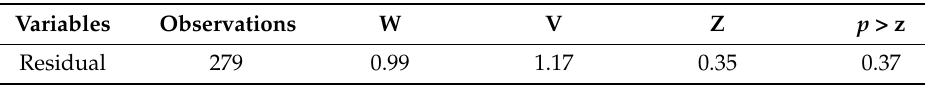
Figure 2. Residual distribution. Table 4. Shapiro–Wilk W test result. Table 3. Baseline regression results.